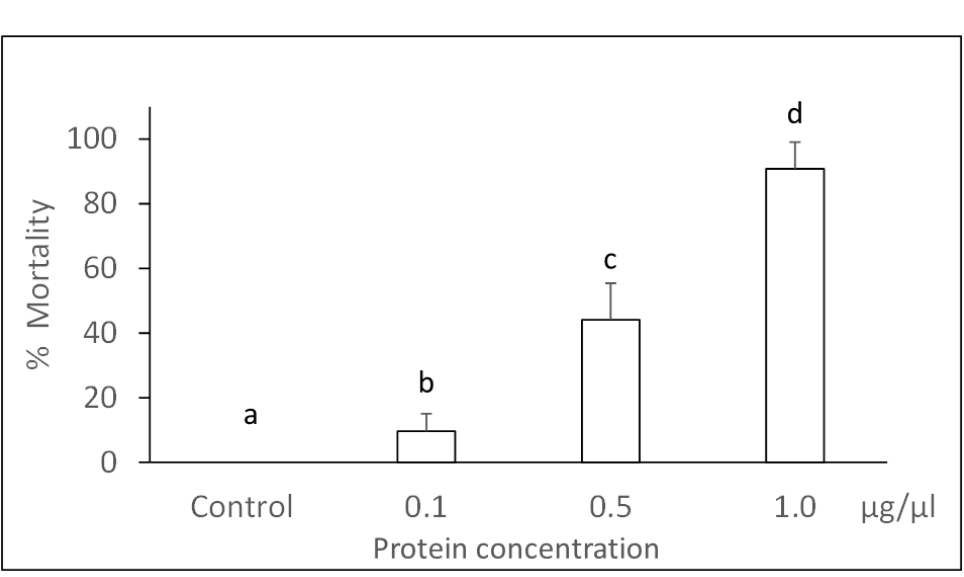
Figure 1. Mortality percentage (mean ± sd) of Panagrellus redivivus exposed for 48 h to different concentrations of the protein extract from the culture supernatant of Brevibacillus laterosporus . Different letters above bars indicate significantly different means (one-way ANOVA, followed by DMRT test, p < 0.001).